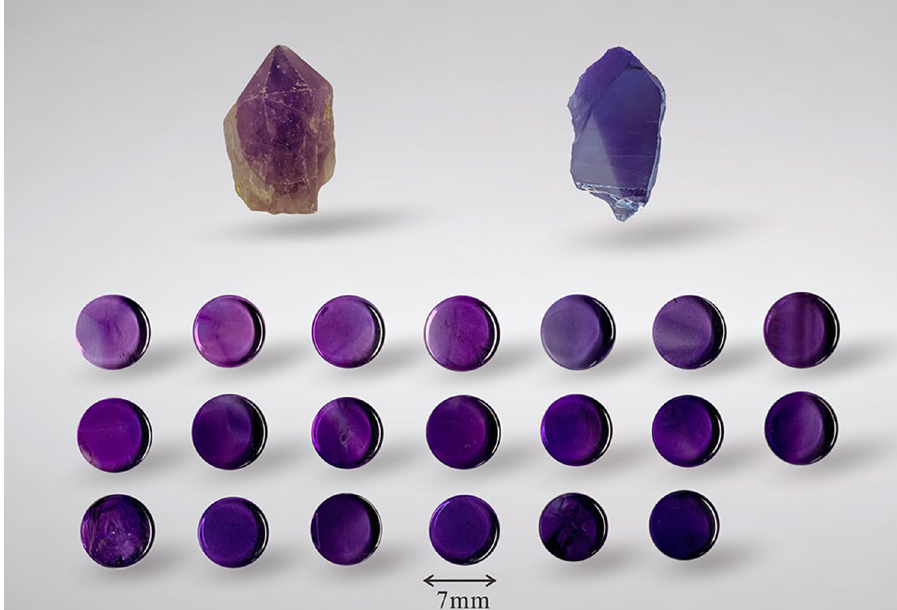
Figure 1. The picture of samples. Round flat samples which are used for color parameters testing have an average weight of 4.01 g and the raw stones at the top of the picture are used for XRD measurement. The lightness of these samples ranges from 21.99 to 53.47, the chroma ranges from 31.80 to 51.25 and the hue angle ranges from 312.1 to 322.5. The figure was taken and drawn by Renping Cheng using CorelDRAW